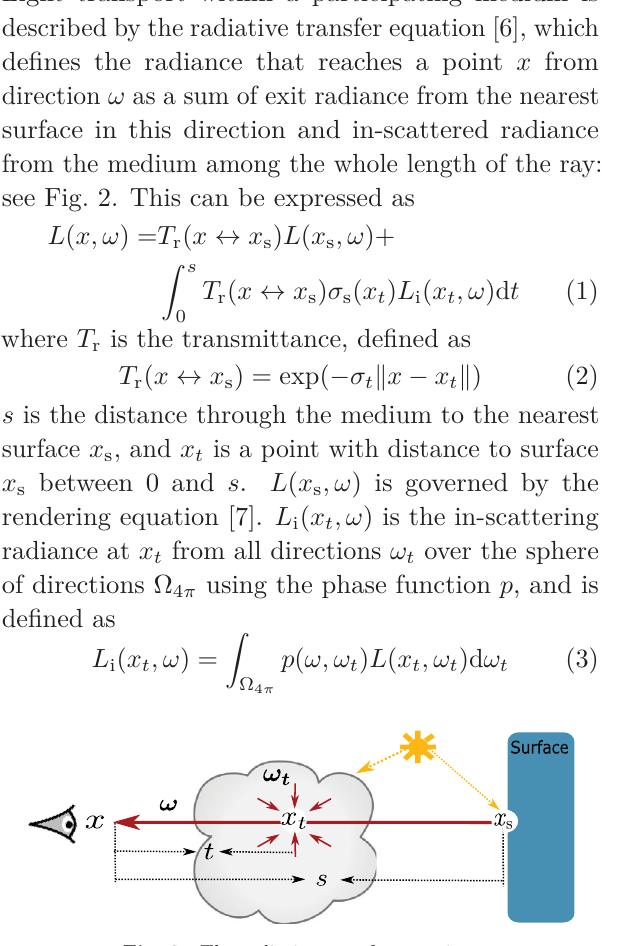
Fig. 2 The radiative transfer